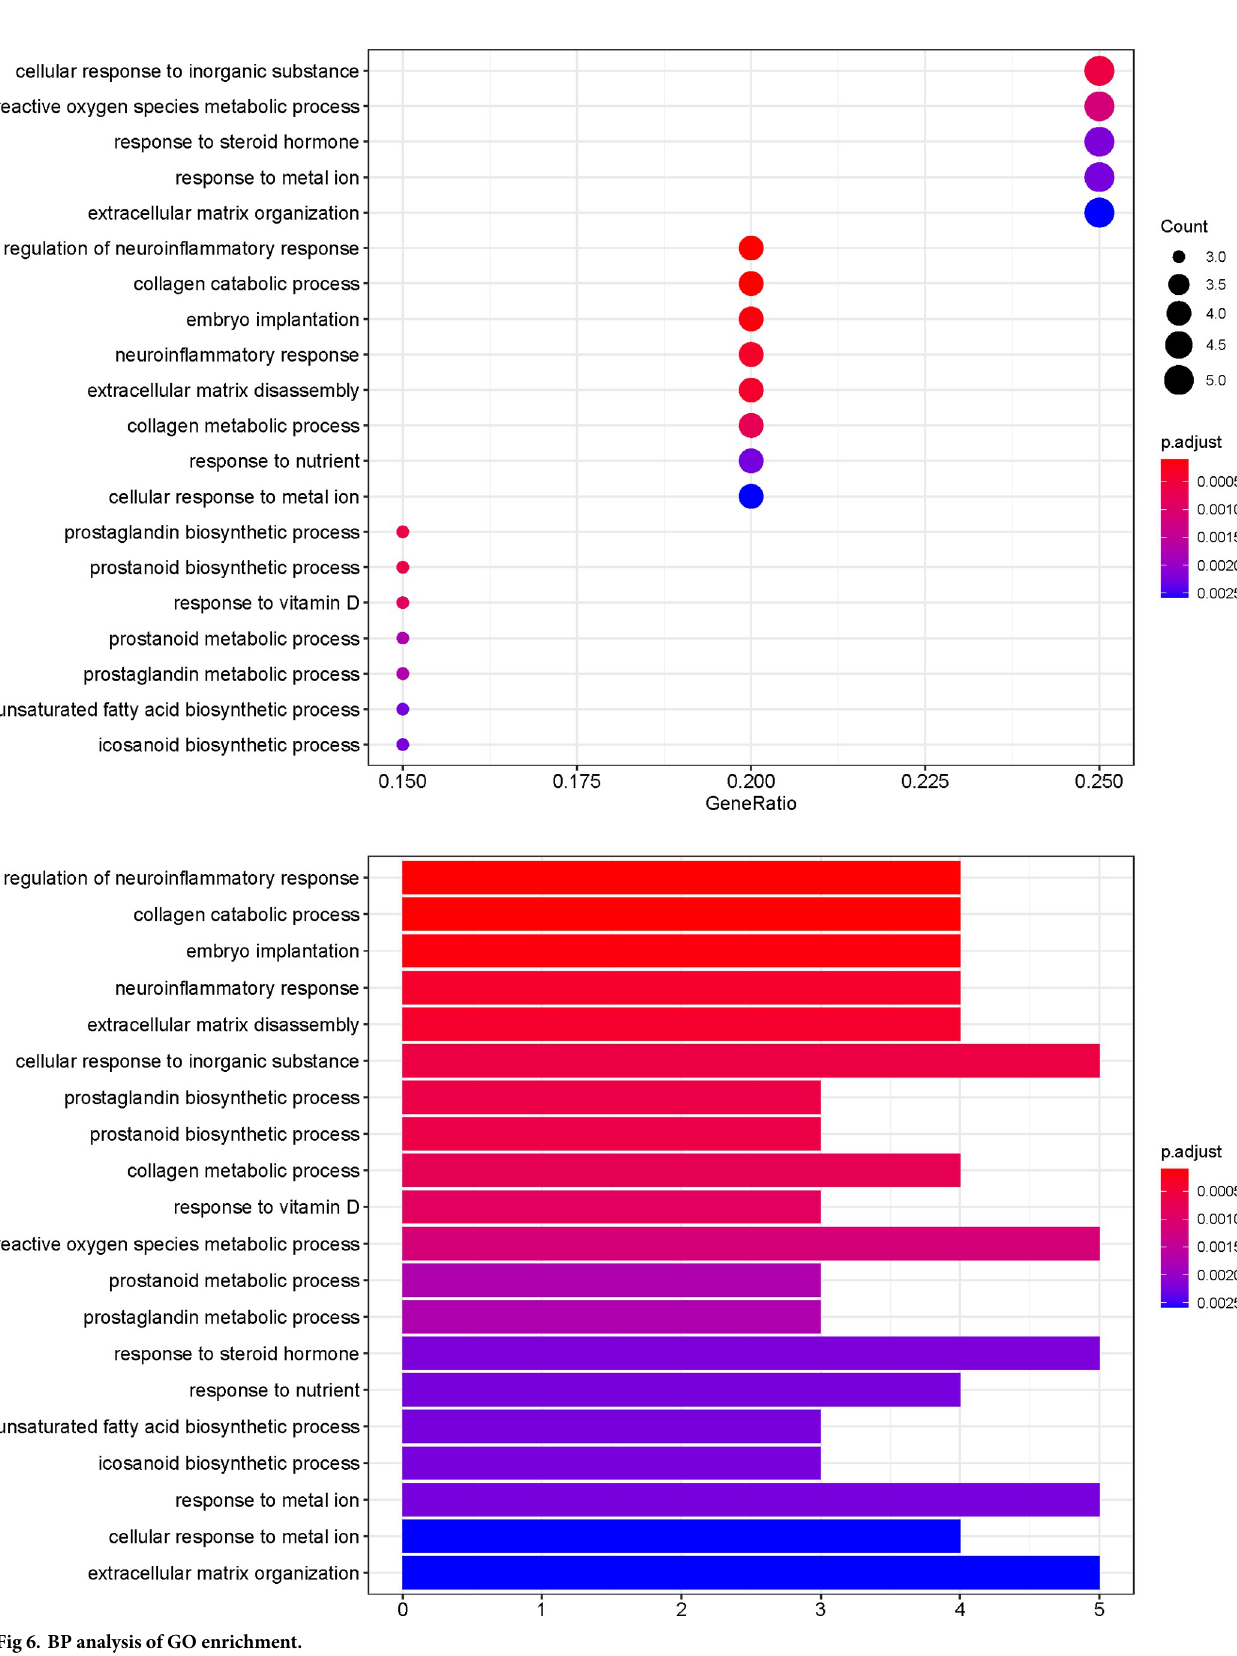
Fig 6. BP analysis of GO enrichment. https://doi.org/10.1371/journal.pone.0252508.g006 PLOS ONE | https://doi.org/10.1371/journal.pone.0252508 June 14,